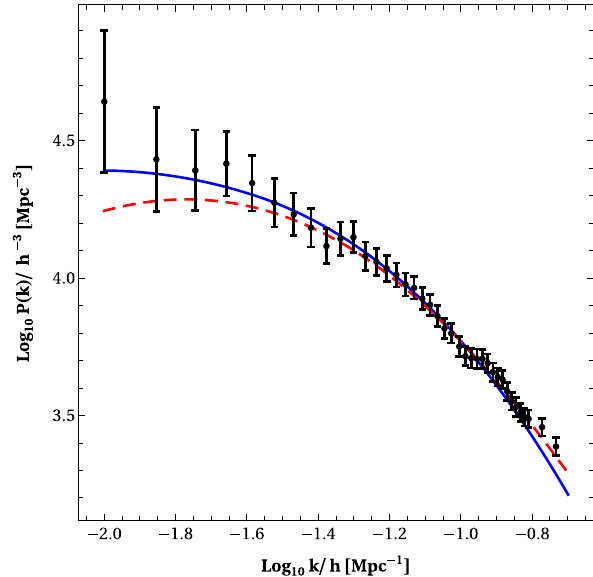
Fig. 6 Solid line: power spectrum of our model using the best fit of χ 2 + χ 2 + χ 2 . One can see that these values provide the linear l 1 BAO SNIa power spectrum which is compatible with the 2dFGRS data. Dashed line: power spectrum obtained by BBKS transfer function with (cid:3) CDM energy